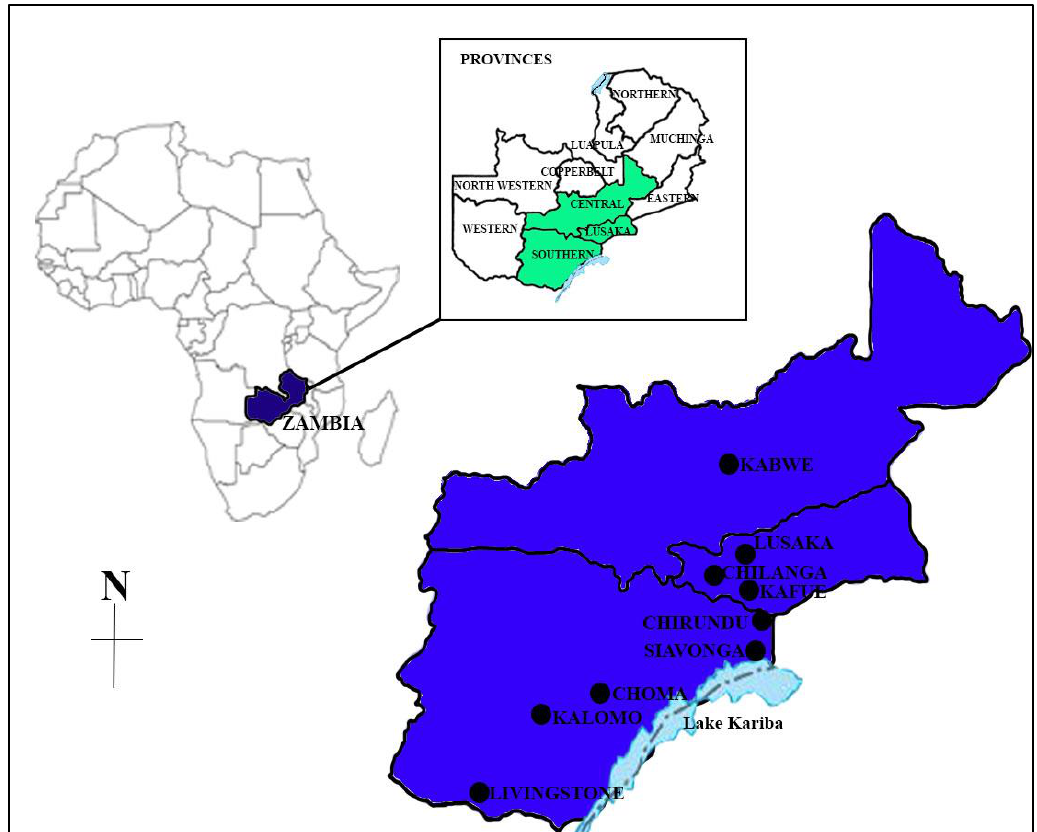
Figure 1. Map of Zambia showing Lusaka and central and southern provinces and nine districts within (Kabwe, Lusaka, Chilanga, Kafue, Chirundu, Siavonga, Choma, Kalomo, and Livingstone) which are a high aquaculture production region in Zambia and the study area.